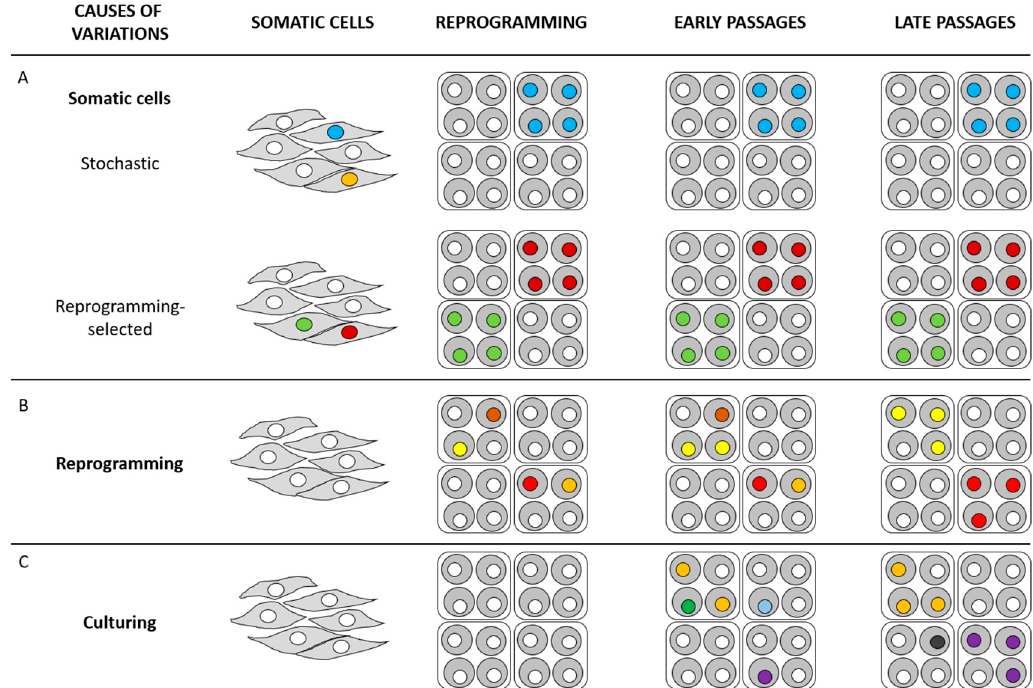
Figure 1. Origin of genetic variations in human induced pluripotent stem cells (hiPSCs). Genetic variations of hiPSCs may have at least three origins. ( A ) Pre-existing variations in parental somatic cells. If a pre-existing genetic variation does not influence the reprogramming process, iPSC generation can occur in a stochastic manner; in this way, it is possible that the cell with the genetic variation highlighted as a blue nucleus progresses in reprogramming, while the cell with the genetic variation highlighted as an orange nucleus does not generate any iPSC clone (stochastic). Differently, if a pre-existing genetic variation confers an advantage in the reprogramming process (garnet and green nuclei), reprogramming preferentially takes place in these cells (reprogramming-selected). ( B ) Reprogramming-induced mutations that occur during the reprogramming process. Mutations conferring advantages in self-renewal and/or proliferation eventually prevail the culture (red and yellow nuclei); mutations being deleterious for cell survival are selected against in culture (brown and orange nuclei). ( C ) Passage-induced mutations that arise during the prolonged culture. Analogously to the mutation selection described in ( B ), some mutations can prevail in culture (purple and orange nuclei), while others can be selected against in culture (green and sapphire blue nuclei). Prolonged culture can promote the appearance of further mutations in late passage (black nucleus). White nuclei represent cells with no genetic variations.